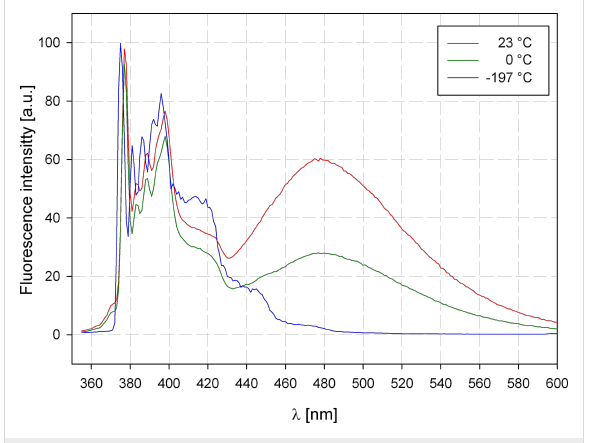
Figure 4: Fluorescence spectra of AR 32a in EPA at different tempera- tures ( c = 5·10 − 6 mol/L).